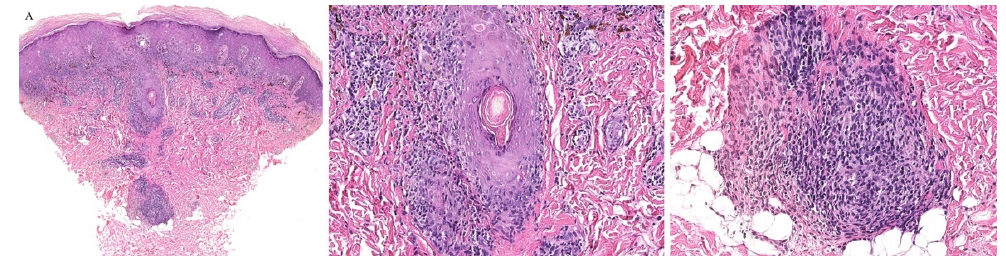
Figure 5. ( A – C ) Lupus erythematosus with periadnexal inflammation.